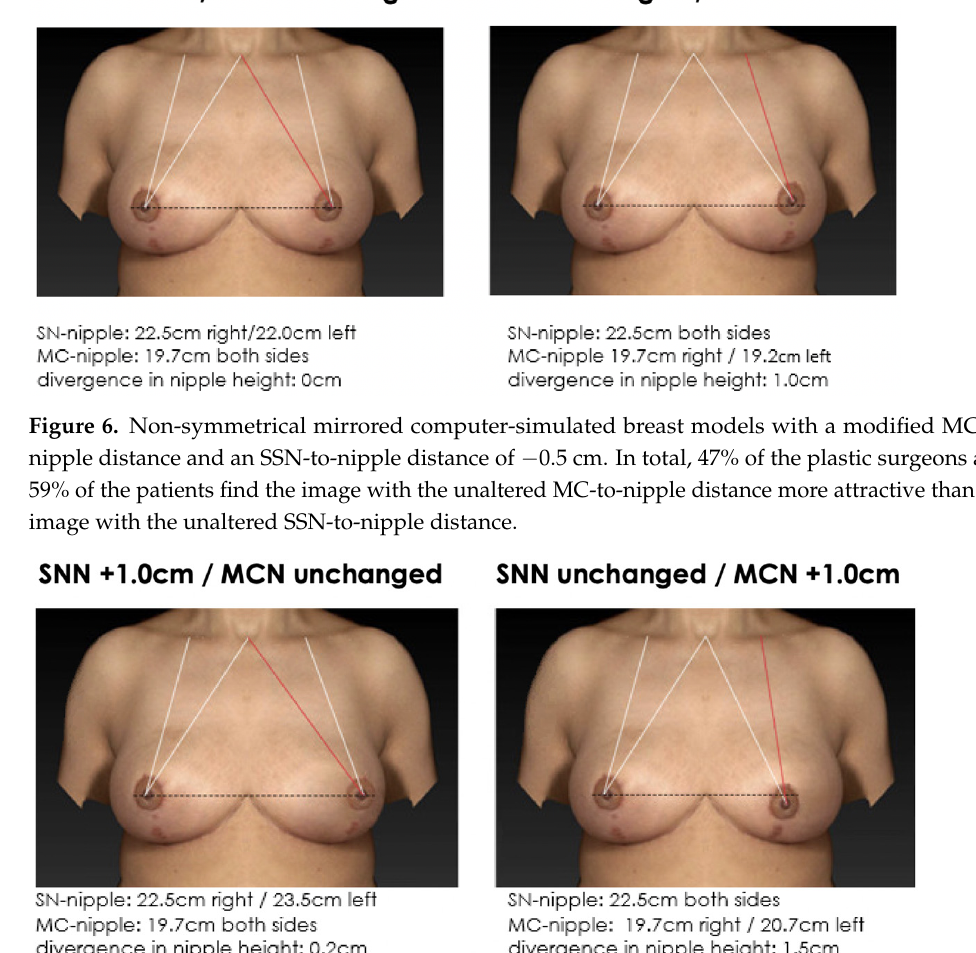
Figure 8. Non-symmetrical mirrored computer-simulated breast models with a modified MC-to- nipple distance and an SSN-to-nipple distance of − 1.0 cm. In total, 98% of the plastic surgeons and 99% of the patients find the image with the unaltered MC-to-nipple distance more attractive than the image with the unaltered SSN-to-nipple distance.